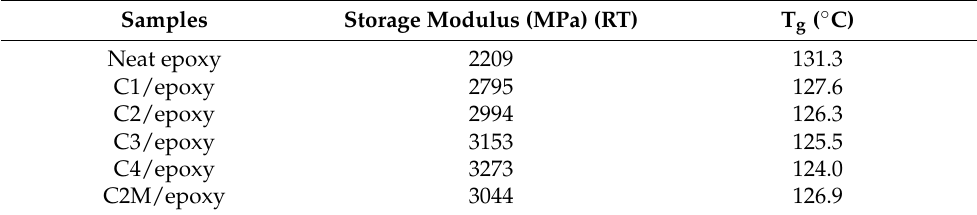
Table 1. Dynamic mechanical properties of neat epoxy, ACSF/epoxy composites and MXene func- tionalized ACSF/epoxy